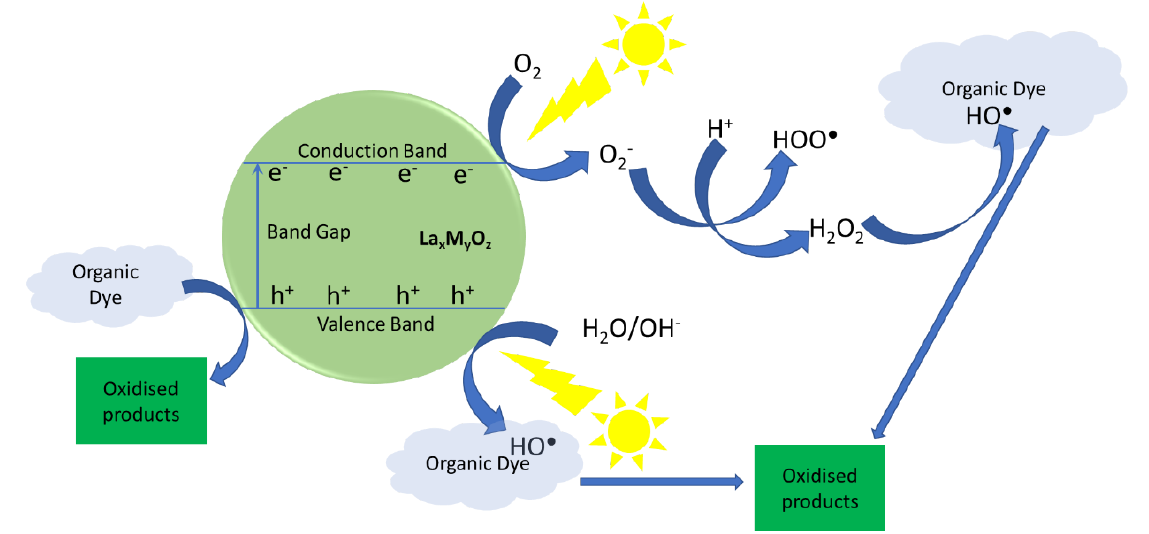
Figure 11. Schematic representation of the organic dye degradation driven by the photocatalytic activity of La-nanocomposites.